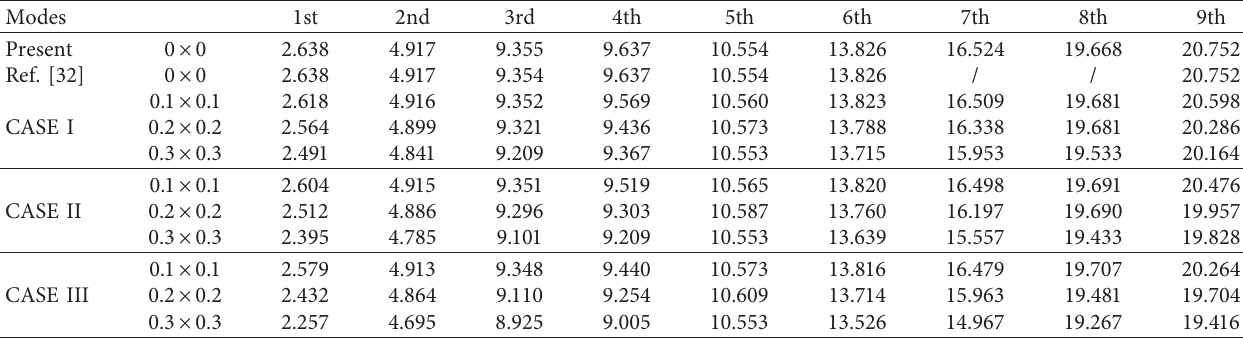
Table 5: Nondimensional frequencies of the cross-ply laminate ([0/90]s) with SSSS boundary condition, E 1/ E 2 � 20, and a � b � 10h and for different patch sizes and